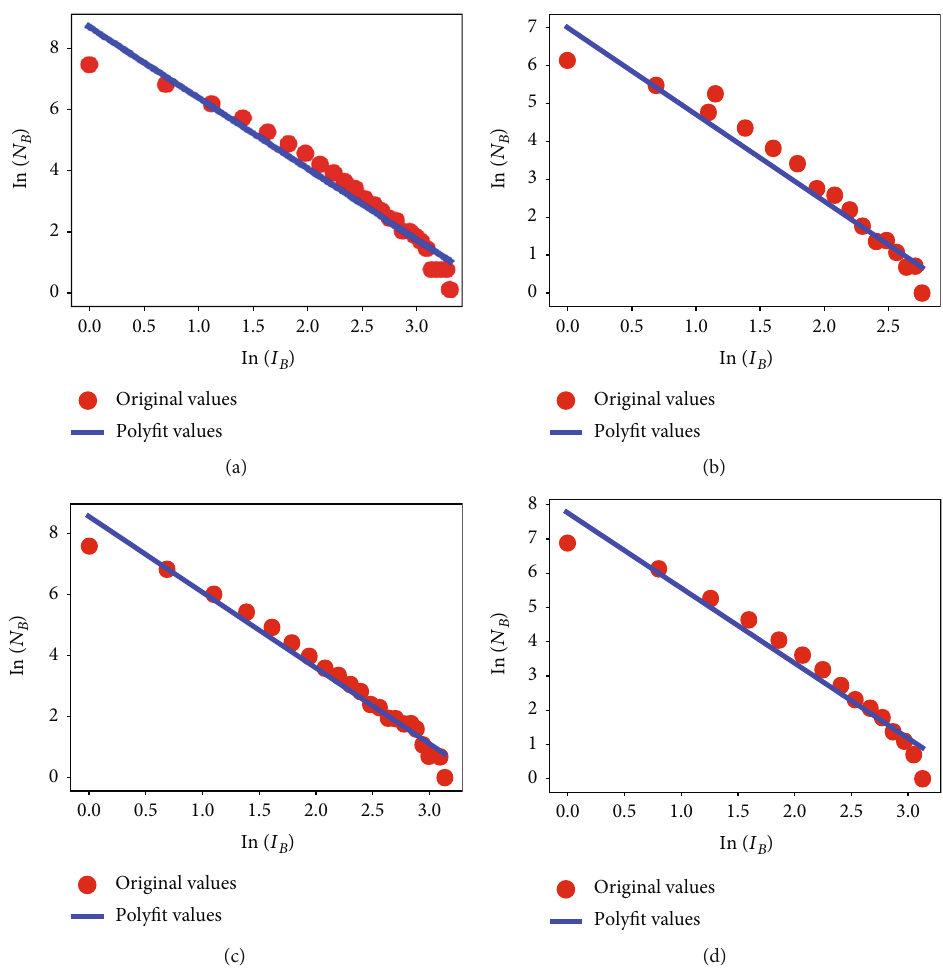
ð l ÞÞ ~ ln ð l Þ : (a) 14.1%, (b) 21.1%, (c) 24.6%, and (d) B B B